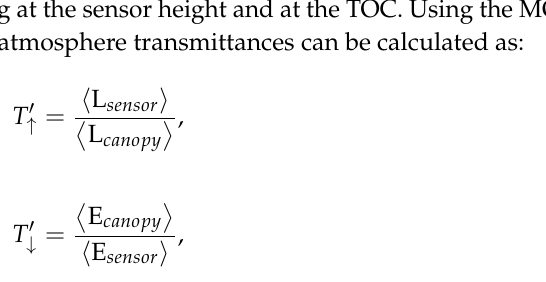
Figure 1. Relationships between the aerosol optical depth (AOD), radiative transfer path length (RTPL), and the upward/downward atmospheric transmittance for a fixed elevation and atmospheric profile at the 760.6 nm (O 2 -A band) and 757.8 nm (shoulder of the O 2 -A band) based on the simulations made by MODTRAN 5. The spectral resolution is 0.31 nm. The mid-latitude summer atmospheric profile was used and the altitude was set as 1.5 km.